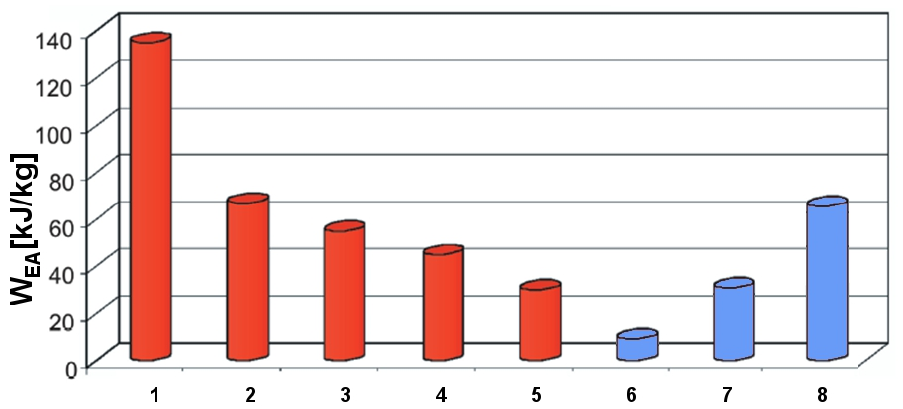
Figure 17. W EA depending on material type: 1—carbon/polyetheretherketone (PEEK), 2—car- bon/epoxy, 3—glass/epoxy, 4—short glass fibers/epoxy, 5—steel, 6—titanium (single layer), 7—ti- tanium (double layer), 8—titanium (triple layer)